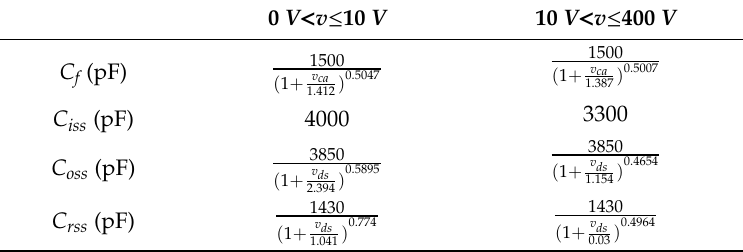
Table 3. Specification of nonlinear junction capacitances.